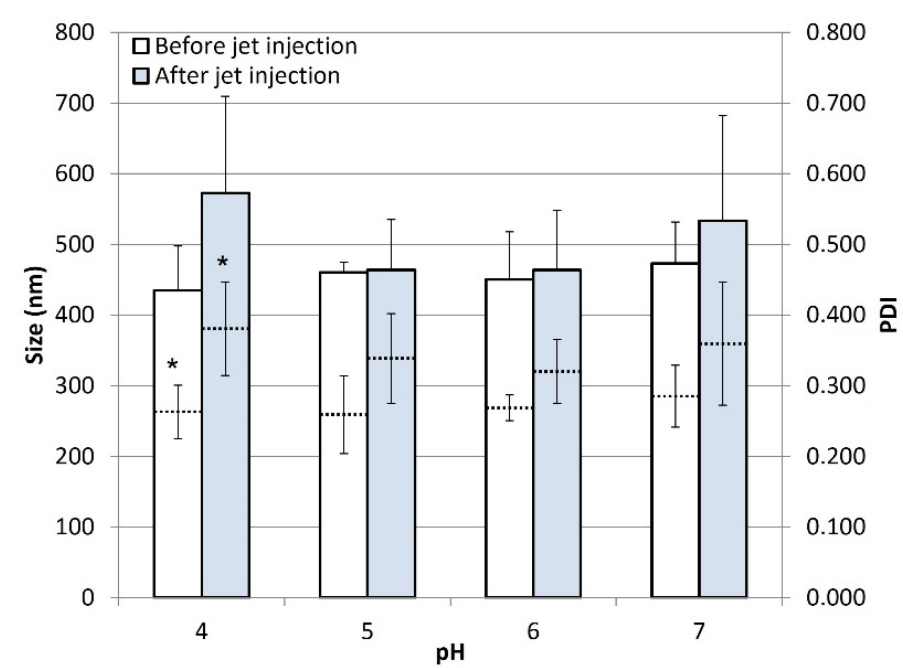
Figure 2. Z average (full bars) and PDI (dotted lines) of DCF NS before and after jet injection across a skin specimen. Values represent the average ± standard deviations of n = 3 replicates. Pairs labelled with * indicate a difference with p < 0.05. Difference between unlabeled pairs have p > 0.05.